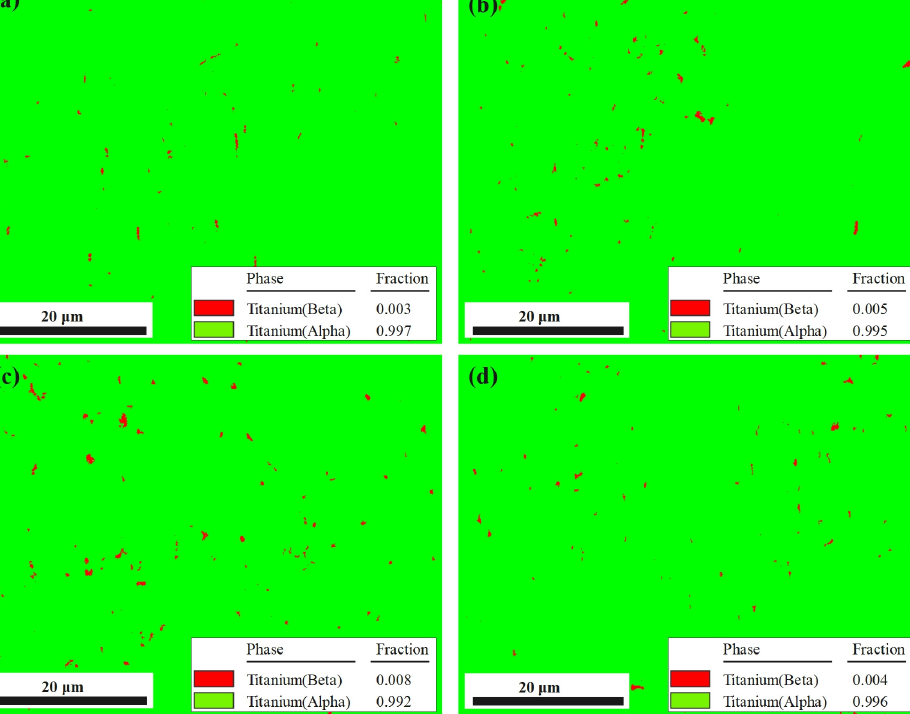
Figure 7. The phase distributions and contents in samples before and after stress relief treatments: ( a ) #0 (untreated); ( b ) #5 (TVSR: 380 °C, 400 MPa); ( c ) #1 (VSR: 400 MPa); ( d ) #2 (TSR: 580 °C). The content of α phase in the sample without stress relief treatment (Figure 7a) is 99.7%; after TVSR treatment (Figure 7b), the content of α phase is 99.5%. In the samples of VSR (Figure 7c) and TSR (Figure 7d) treatments, the content of α phase is 99.2 and 99.6%, respectively. The maximum difference of phase content of the four samples is only 0.5%, which indicates that stress relief treatment on SLMed Ti-6Al-4V samples basically does not change the phase content and distribution.